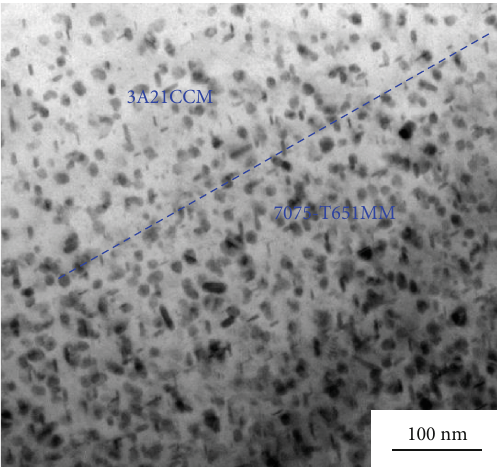
Figure 8: TEM photo of the fusion zone.